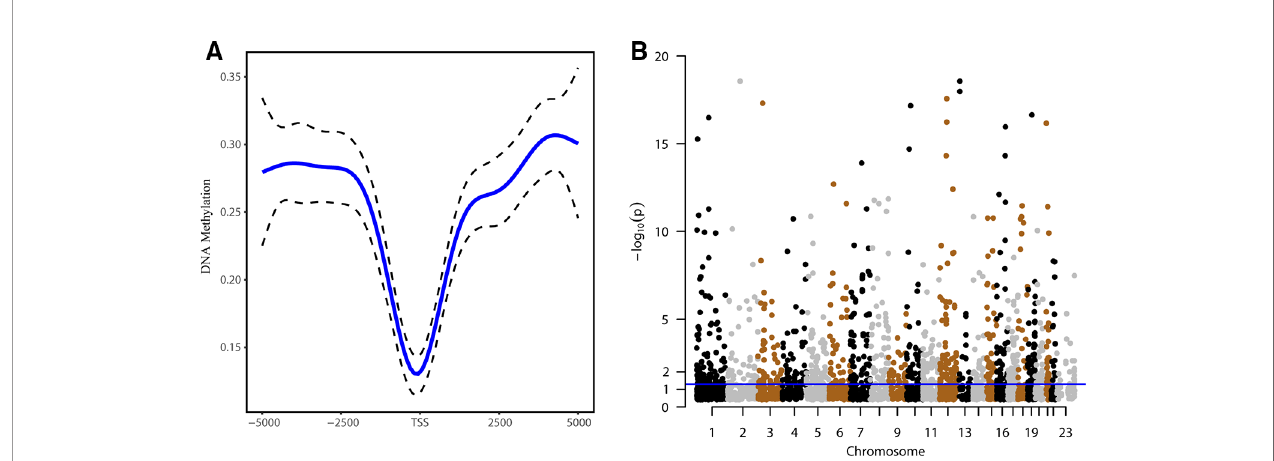
FIGURE 1 | DNA methylation patterns of genes encoding long noncoding RNAs (lncRNAs). (A) Distribution of the methylation levels around lncRNA genes in sperm ranging from 5 kb upstream to 5 kb downstream of the transcription start site (TSS). (B) Manhattan plot of CpG sites in the promoter regions of lncRNA genes; dots above the blue line indicate CpG sites with P value <